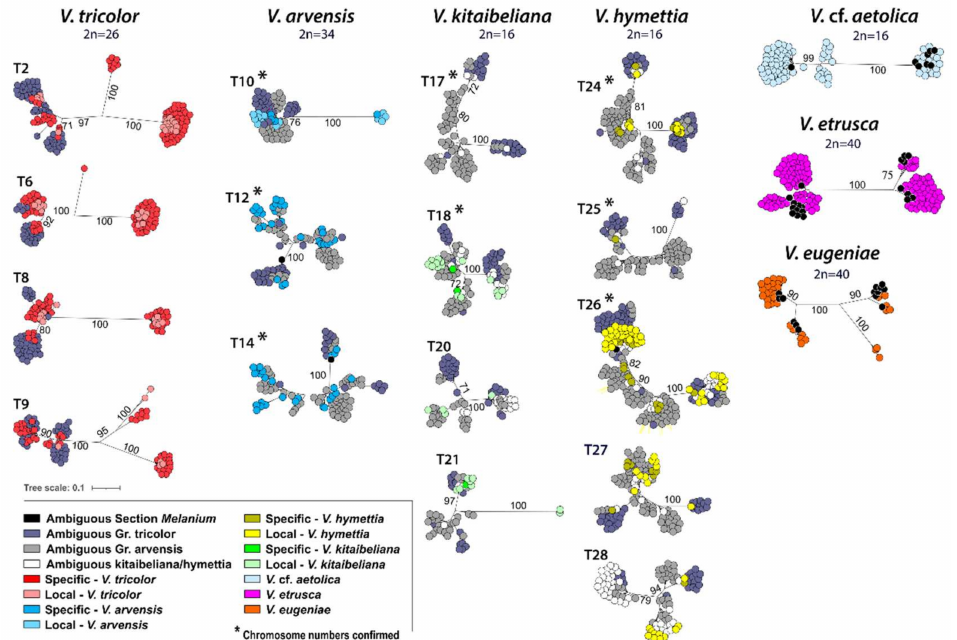
Figure 4. Unrooted maximum likelihood phylograms of the 5S-IGS sequences, filtered for abundance ( ≥ 25) and length ( ≥ 280 bp), in each sample; sequence class composition and the chromosome number of species/samples are reported.